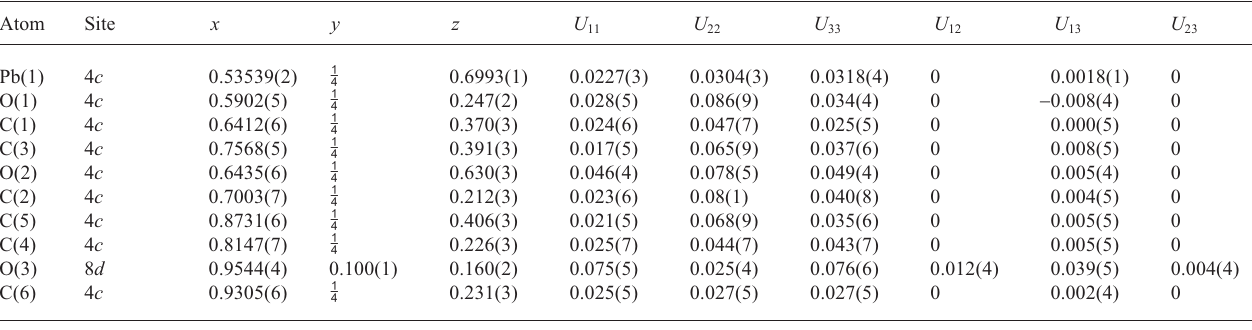
Table 3. Atomic coordinates and displacement parameters (in Å 2 )